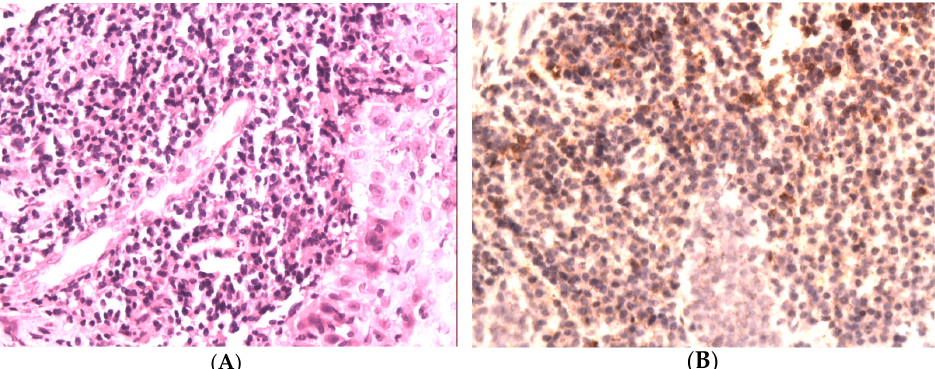
Figure 3. ( A ) Massive, subepithelial, mononuclear inflammatory infiltrates; hematoxylin and eosin. (H + E), magn. 200×. ( B ) Immunohistochemical staining for IgG4. The immunoexpression of IgG4 was present in most of the mononuclear cells of inflammatory infiltration (>50%), magn. 200×.